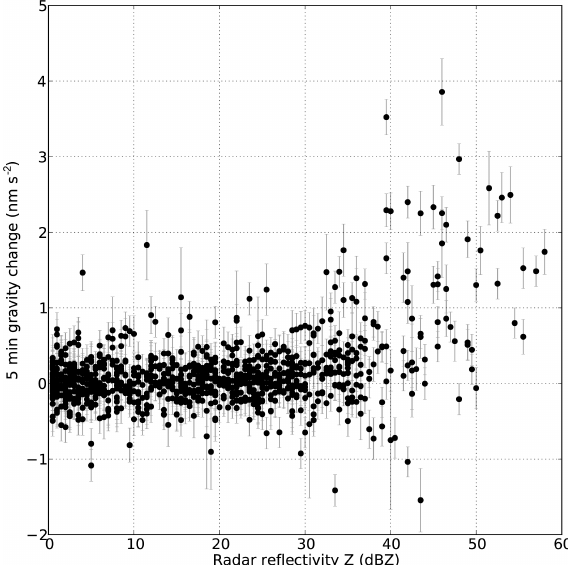
Figure 4. The 5min gravity change as a function of radar reflec- tivity based on 14 days with heavy rainfall. The errors bars show the errors caused by instrumental errors and correction of pressure